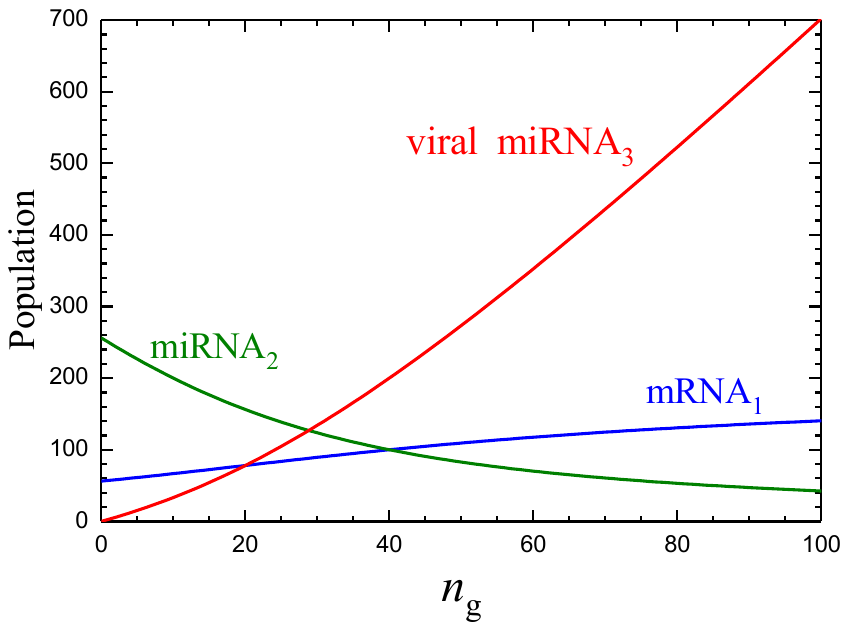
Figure 1. mRNA 1 , miRNA 2 , and miRNA 3 populations as a function of the G population according to (19) with w 1 / k = 200, w 2 / k = 400, κ 12 / k = κ 23 / k = 0.01, and κ 3 / k = 10. The model contains also the P 1 population. The latter population (not shown here and below in other figures) is just proportional to the mRNA 1 population.